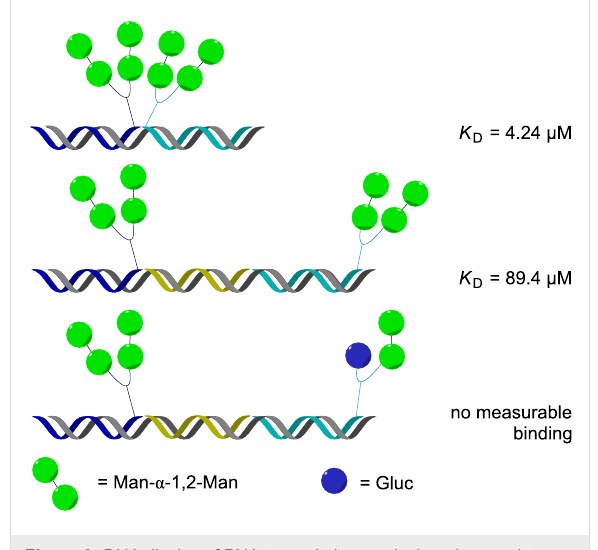
Figure 3: DNA display of PNA-tagged glycans designed to emulate HIV's gp120